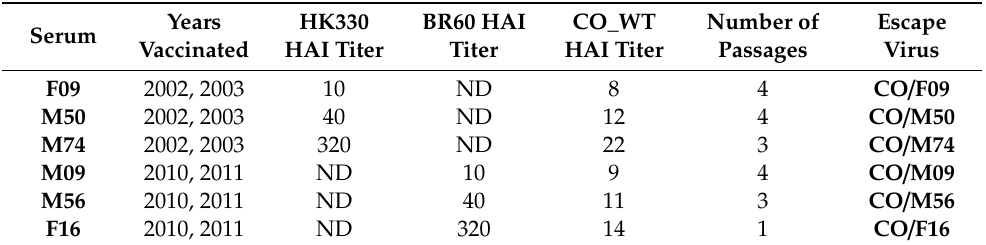
Table 1. Serum and Victoria lineage viruses. The designation for each post-vaccination serum (column 1) and year of vaccine receipt (column 2) are listed. Hemagglutination inhibition (HAI) titers toward IBV vaccine component (from [25]) are shown in columns 3 and 4. HAI titers (geometric mean from four replicates) for the sera toward the contemporary B / Colorado / 06 / 2017 virus are in column 5. The number of passages used to attain the escape virus are shown and the name of each escape virus, which incorporates the serum name, are shown in the last two columns. HK330, B / Hong Kong / 330 / 01; BR60, B / Brisbane / 60 / 2008; CO_WT, B / Colorado / 06 / 17; ND, not